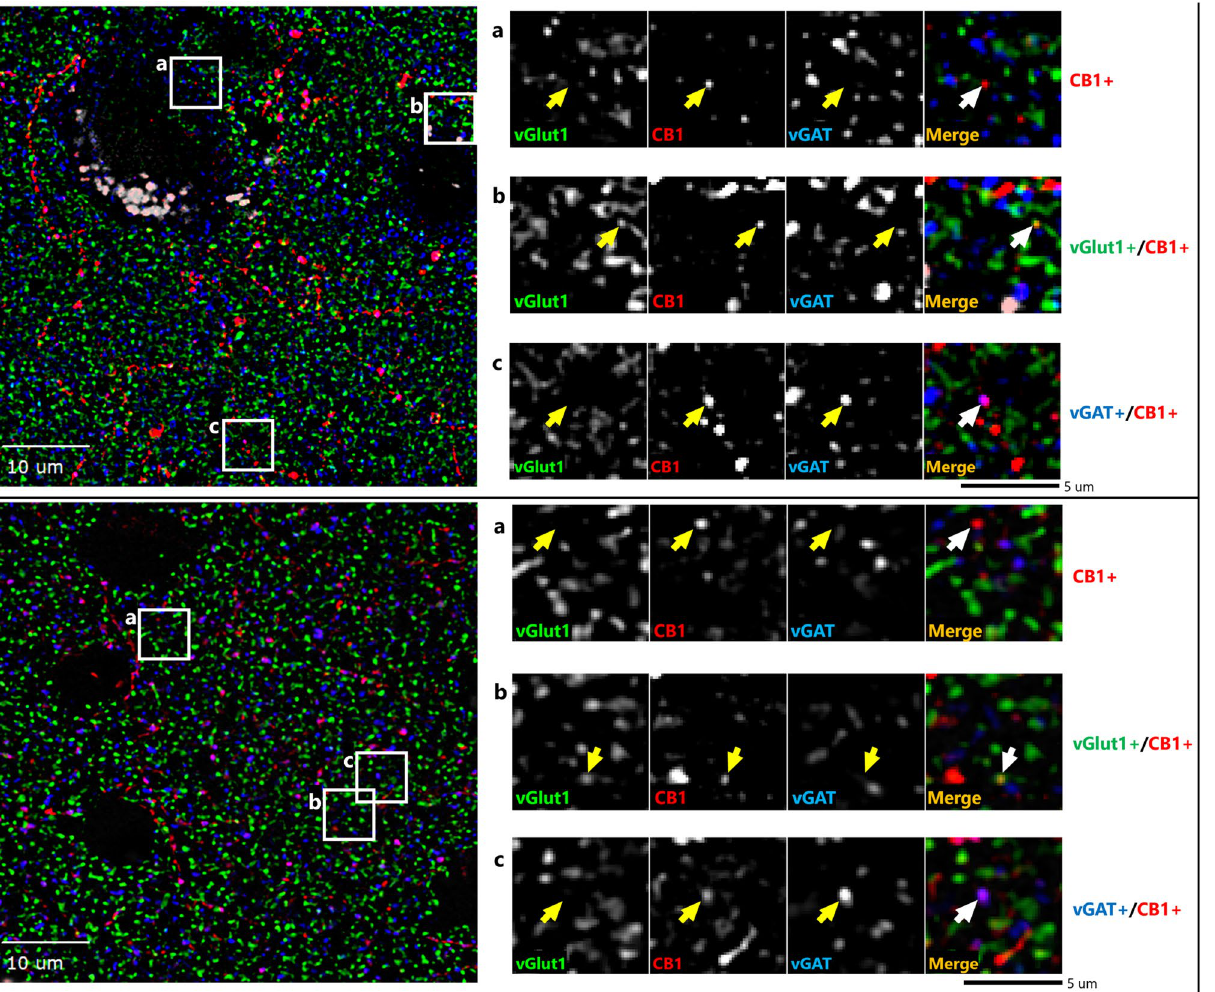
Figure 1. Sample micrograph of immunohistochemical staining in both human (top) and monkey (bottom) cortex. Left panels: Puncta with vGlut1 + (green), vGAT + (blue) & CB1R + (red) immunoreactivity are distributed throughout the image field. Right panels: Enlarged images with arrows identifying puncta with antibody immunoreactivity toward a single or multiple